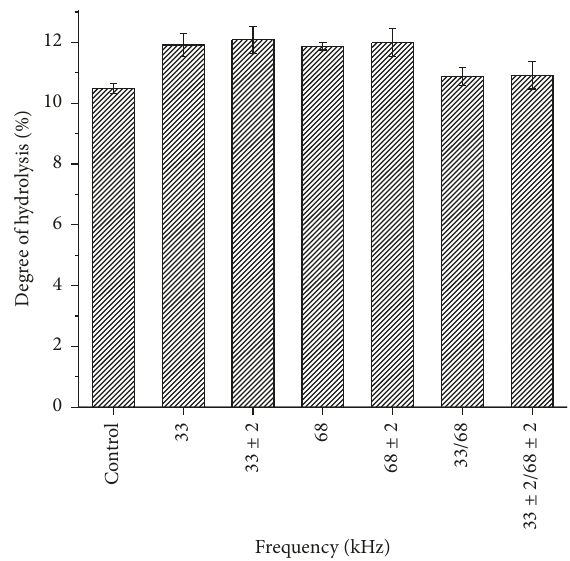
Figure 3: Effects of pretreatment with ultrasound bath with four different working modes and two frequencies on the degree of hydrolysis of